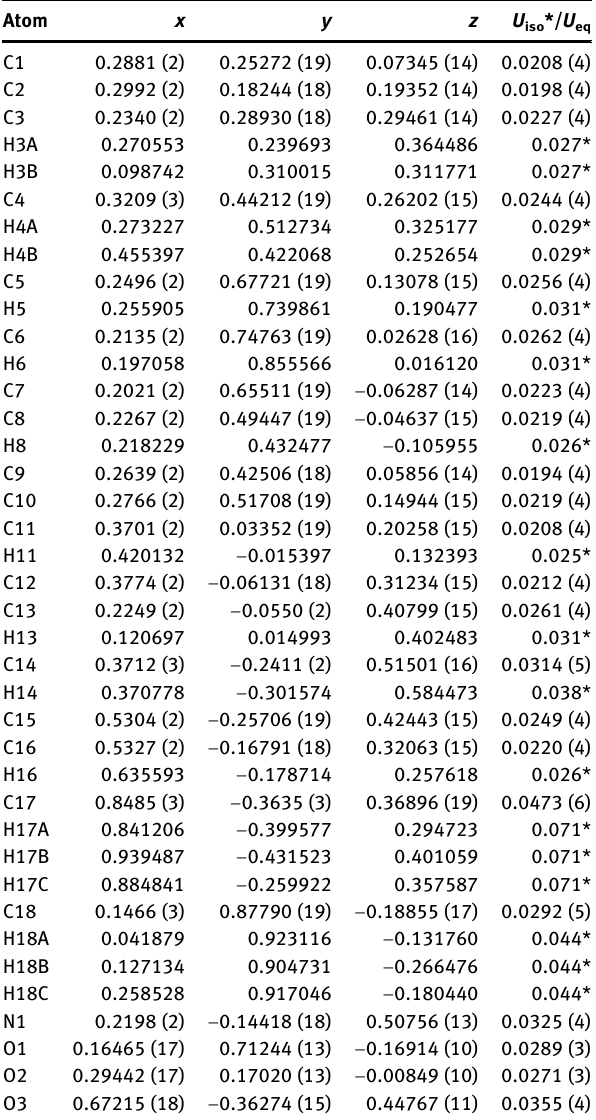
Table  : Fractional atomic coordinates and isotropic or equivalent isotropic displacement parameters (Å 